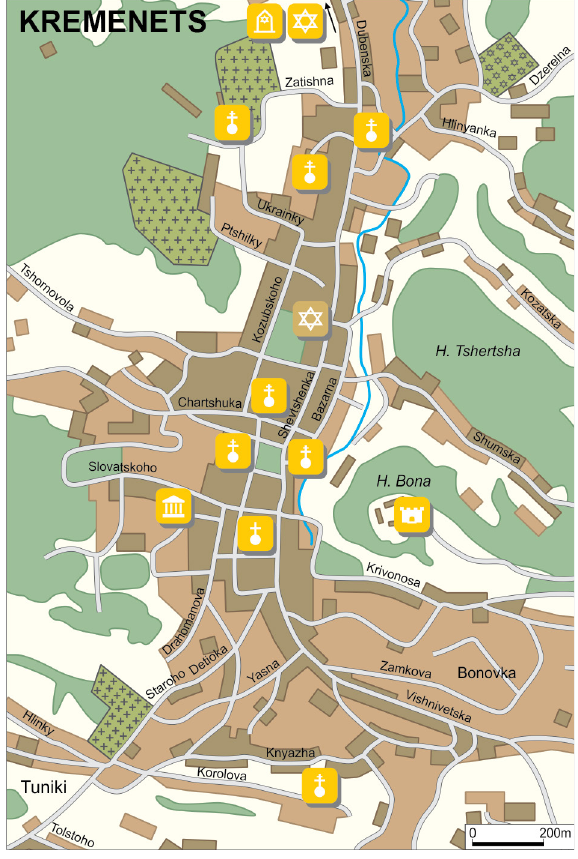
Fig. 2. Kremenets (Ukraine) 1:20,000 – town map designed for the Shtetl Routes guidebook